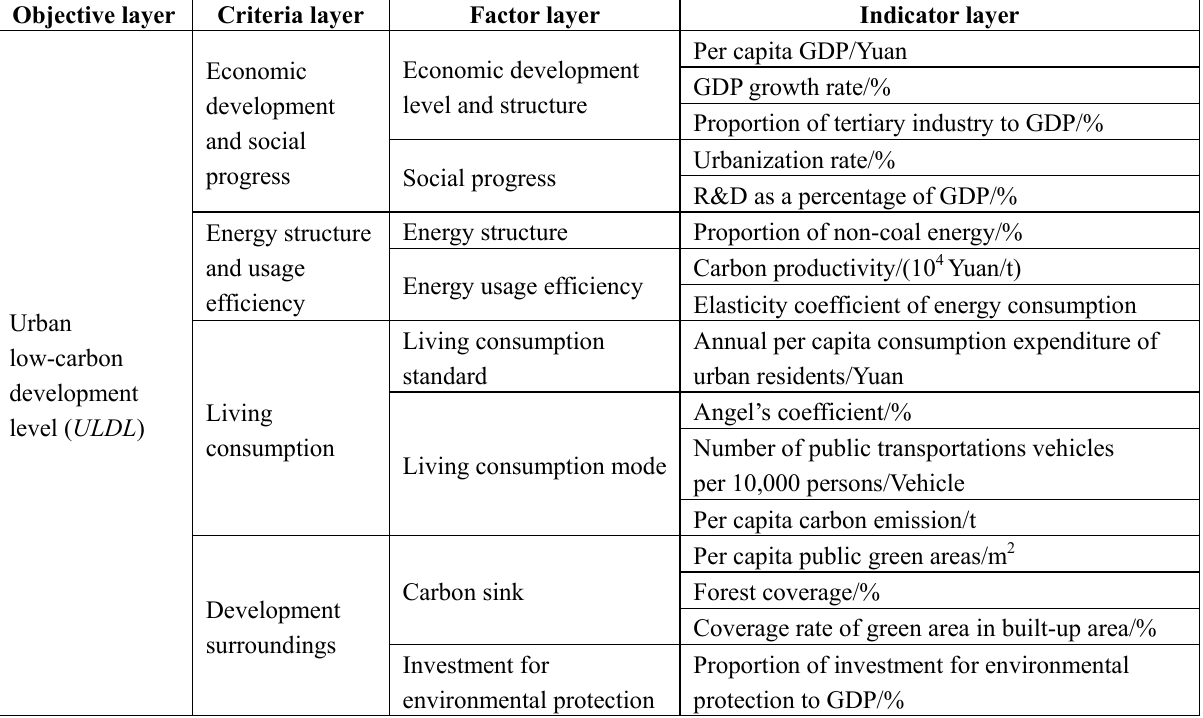
Table 1. Evaluation index system of urban low-carbon development